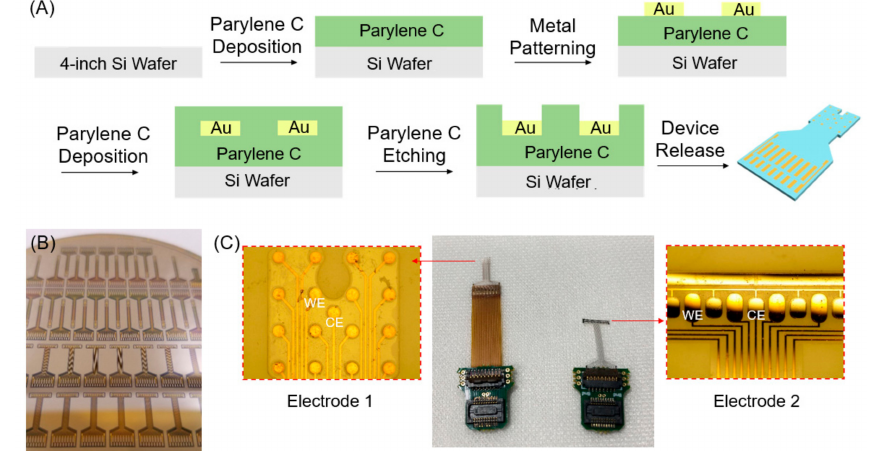
Figure 1. Fabrication process and images of the microelectrode arrays. ( A ) Cross-sectional view of the microelectrode fabrication process. ( B ) Image of the fabricated electrode arrays in a 4-inch wafer. ( C ) Two types of electrode arrays with di ff erent electrode sizes: Electrode 1 with an area of 17,671 µ m 2 ; Electrode 2 with an area of 59,325 µ m 2 (WE: working electrode; CE: counter